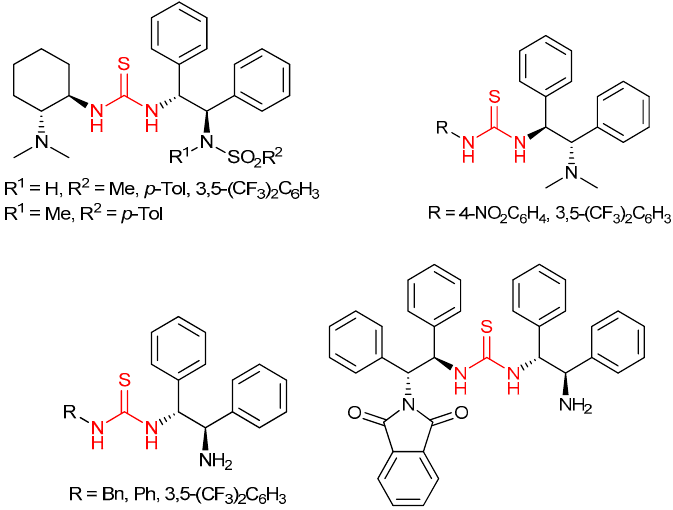
Figure 12. Chiral thioureas based on 1,2-diphenylethylenediamine [176–183].